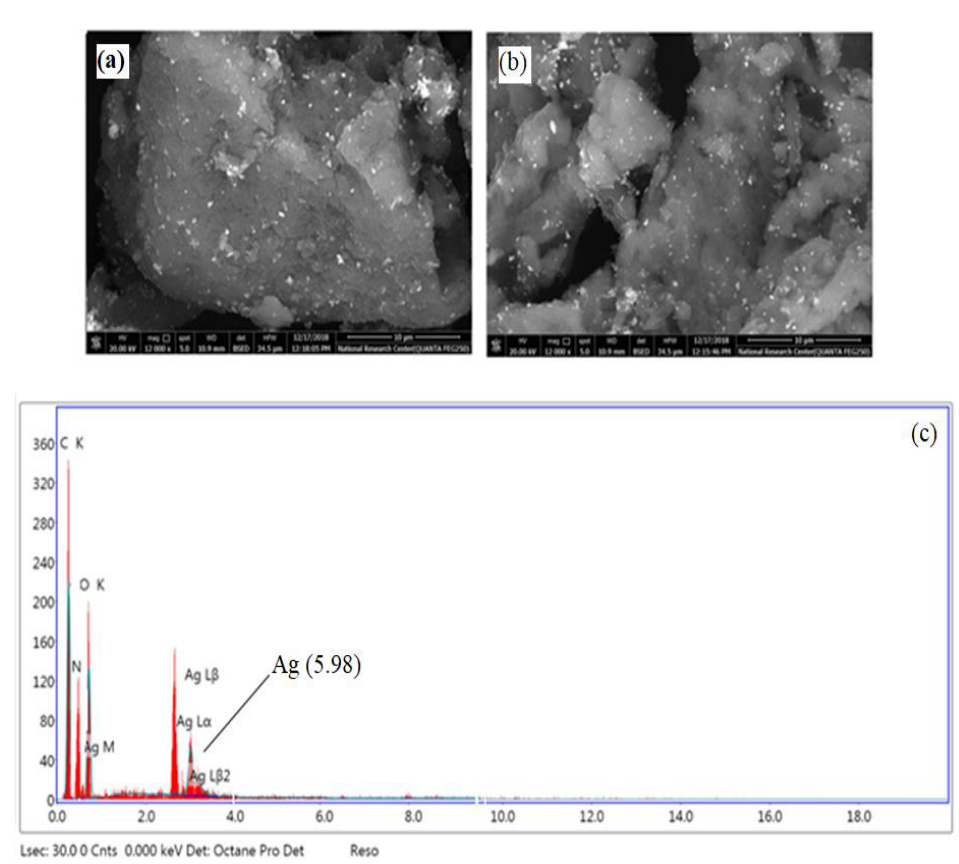
Figure 7. SEM images of: ( a ) H 31 /AgNPs1%; ( b ) H 31 /AgNPs3% and ( c ) EDS of H 31 /AgNPs3%.